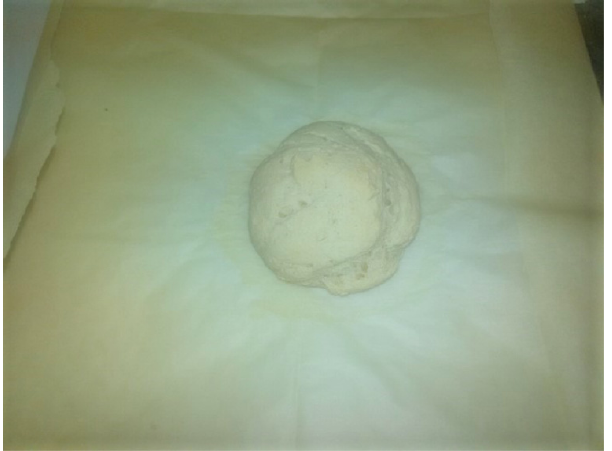
Figure 3. The bread roll obtained by enriched flour after cooking at 180 °C for 30 min.